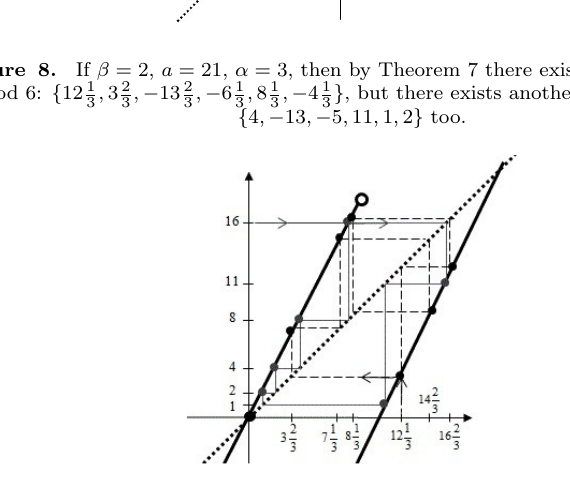
Figure 9. If β = 2, a = 21, α = 9, then there exists periodic orbits of period 6: { 12 1 , 3 2 , 7 1 , 14 2 , 8 1 , 16 2 } and { 16 , 11 , 1 , 2 , 4 , 8 } — both with only positive 3 3 3 3 3 3